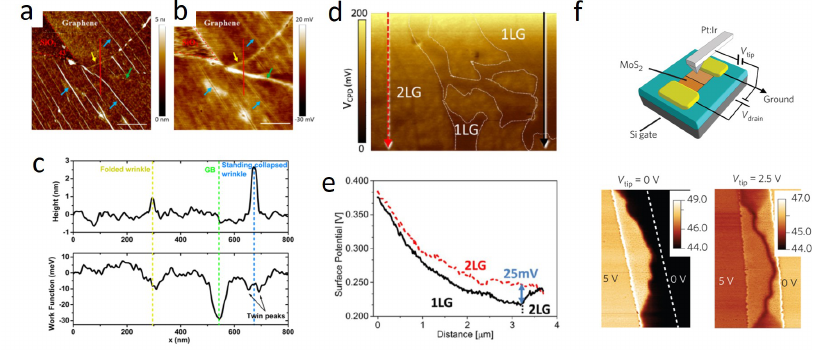
Figure 3. AFM topography ( a ) and Kelvin Probe Force Microscopy (KPFM) mapping ( b ) of standing collapsed wrinkles with various sizes; ( c ) Cross section profiles along the red line marked in (a) and (b). The dashed lines indicate the locations of folded wrinkle, grain boundaries, and standing collapsed wrinkle, respectively, with color coding corresponding to that in (a) and (b). Scale bars in (a) and (b) are 500 nm (adapted from [79]); ( d ) Surface potential map showing decreasing surface potential of single and double layer graphene with NO 2 exposure. The arrows represent the direction of the scan; ( e ) Section profiles along the arrows marked in (d) for single (black) and double (red) layer (adapted from [80]); ( f ) Device scheme and Electrostatic Force Microscopy (EFM) phase images of a bisecting grain boundary (GB) MoS 2 memristor at tip biases V tip = 0 V and 2.5 V. Color scale bars show the EFM phase in degrees. Device bias conditions: V drain = 5 V and V source = V g = 0 V. The dotted lines highlight the metal–MoS2 junctions with less contrast (adapted from [18]).